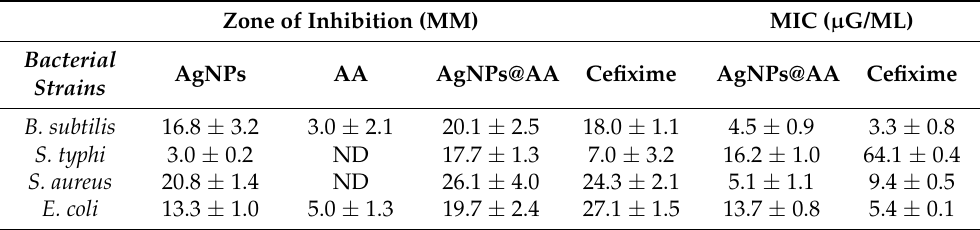
Table 1. Antimicrobial activities of AgNPs against clinically isolated bacterial strains. Zone of Inhibition (MM) MIC ( µ G/ML) Bacterial Strains